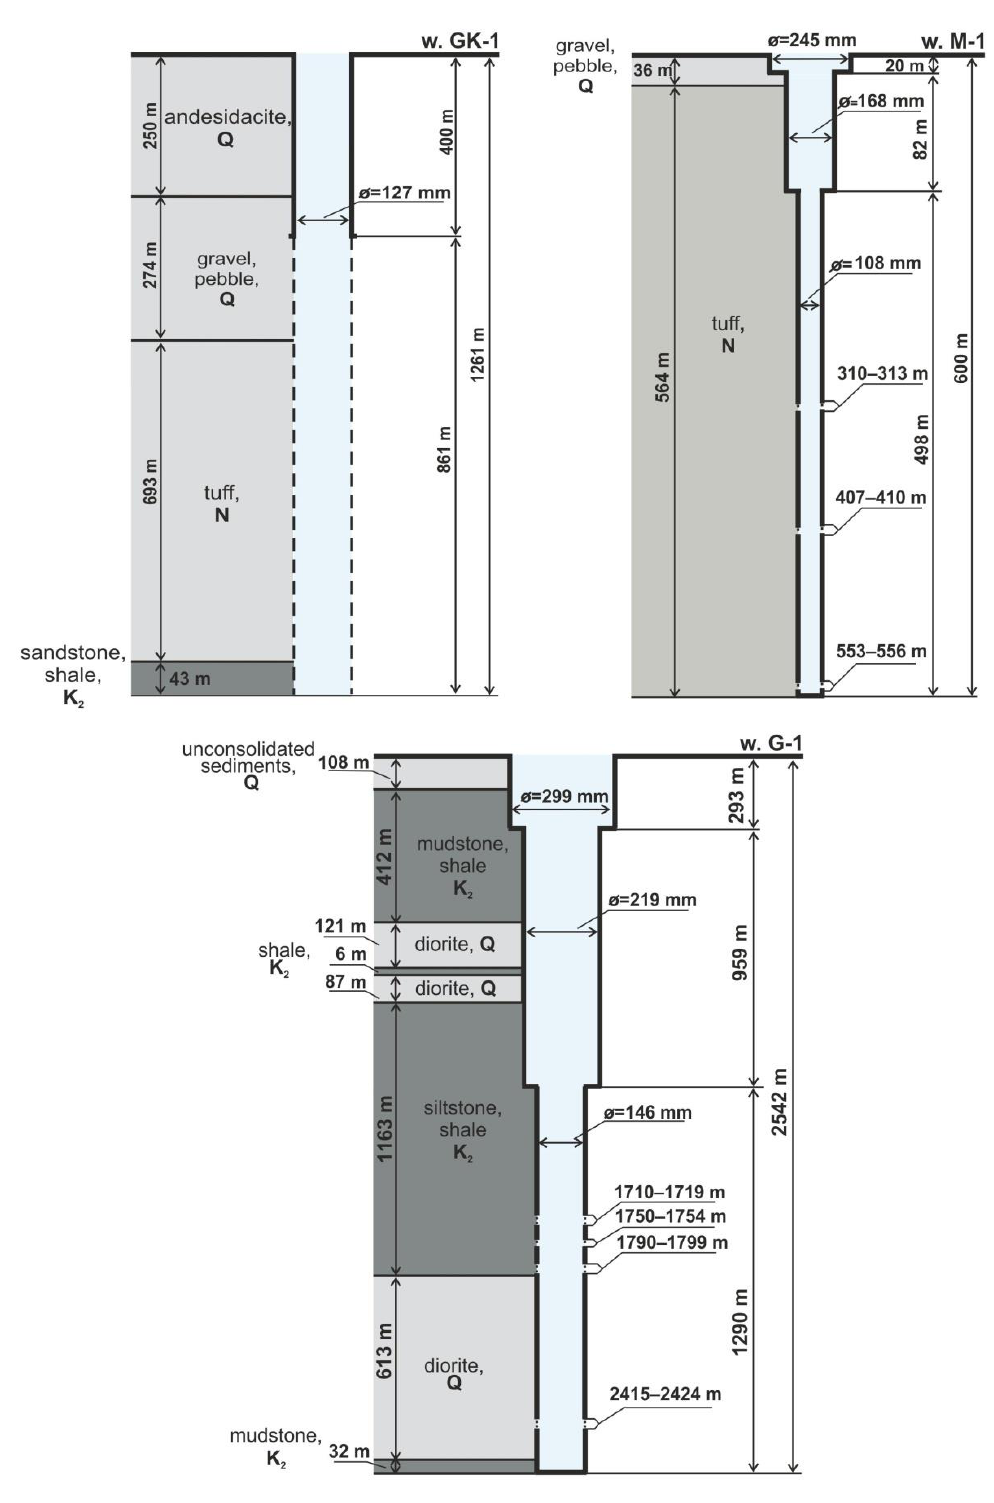
Figure 2. Observation wells.